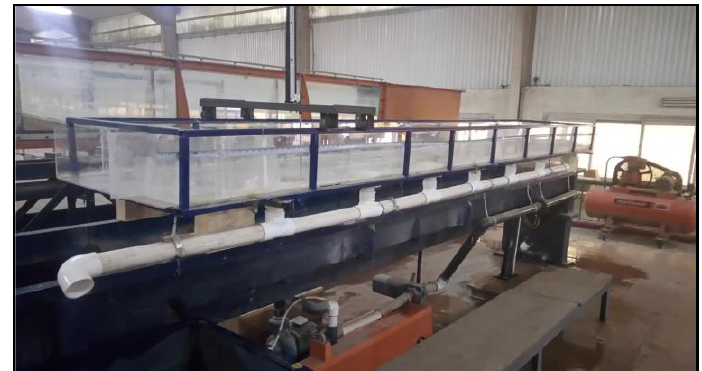
Figure 3. The shape of flume used in the experimental study.